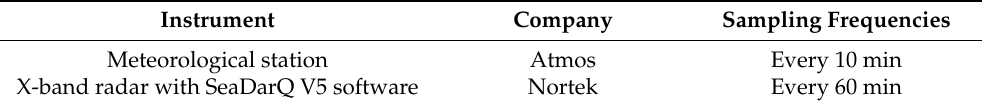
Table 2. Onshore instrumentation and sampling